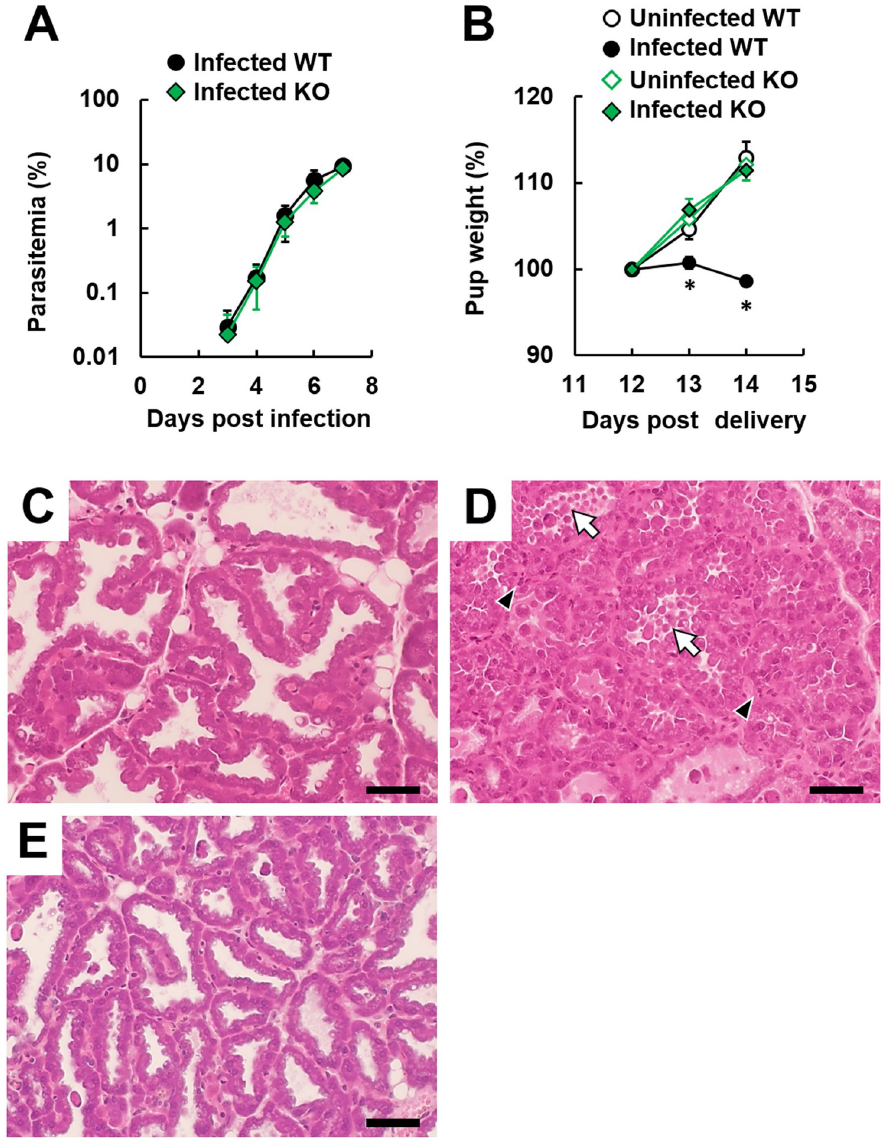
Fig 4. IFN- γ signaling-dependent histological change in the mammary gland tissue of postpartum mice infected with malaria parasites. Wild-type (WT) B6 mice and IFNGR1-KO mice (KO) on day 7 post-delivery were infected with 1 × 10 4 infected erythrocytes of luciferase-expressing Plasmodium berghei ( Pb ) ANKA. Green symbols and lines indicate IFNGR1-KO mice. (A) Course of parasitemia. Results are expressed as means ± standard deviation (SD) of three mice. Experiments were performed in duplicate with similar results. (B) Pup weight. The weight is expressed as a percentage of the value on day 12 post-delivery. Open symbols represent weight of pups born from uninfected mice. Closed symbols indicate weight of pups born from infected mice. Results are expressed as means ± SD of pups delivered by the mother. Experiments were performed in triplicate with similar results. Asterisks indicate a significant difference ( P < 0.05; Tukey-Kramer and Dunnett tests). (C–E) Histological analyses of mammary gland tissue on day 14 post-delivery. (C) Uninfected postpartum WT mice. (D) Infected postpartum WT mice. (E) Infected postpartum IFNGR1-KO mice. Representative hematoxylin and eosin (H&E)-stained placental sections are shown. The scale bar represents 50 μ m. Arrows indicate destruction of an alveolus wall. Arrowheads indicate extensive presence of leukocytes. Experiments were performed in triplicate with similar